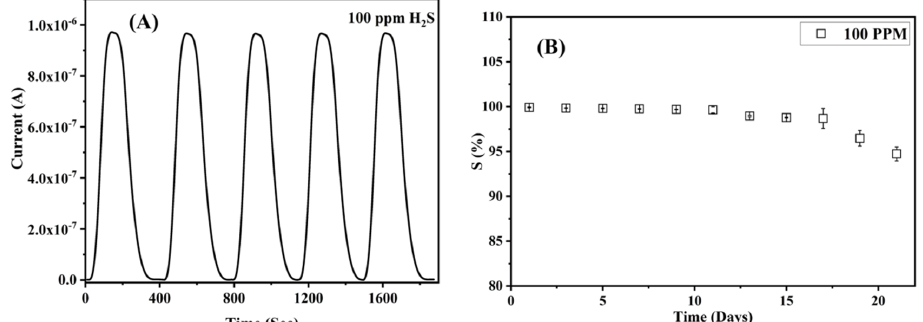
Figure 6. ( A ) Repeatability of the ZnO/PVA/IL membrane at 100 ppm H 2 S. ( B ) Long-term stability of the ZnO/PVA/IL membrane for 21 days at 100 ppm H 2 S gas.